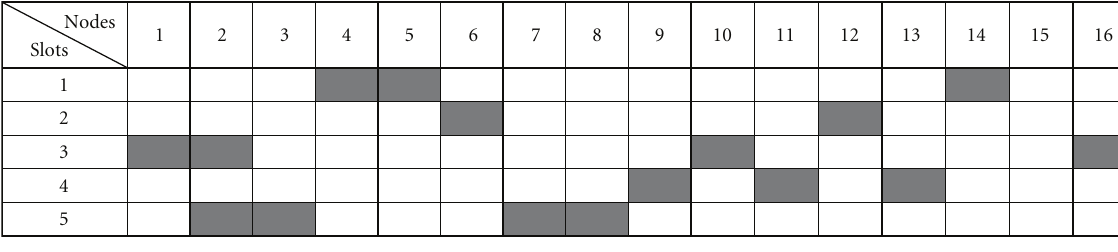
Figure 4: Optimal schedule of 16-station network.